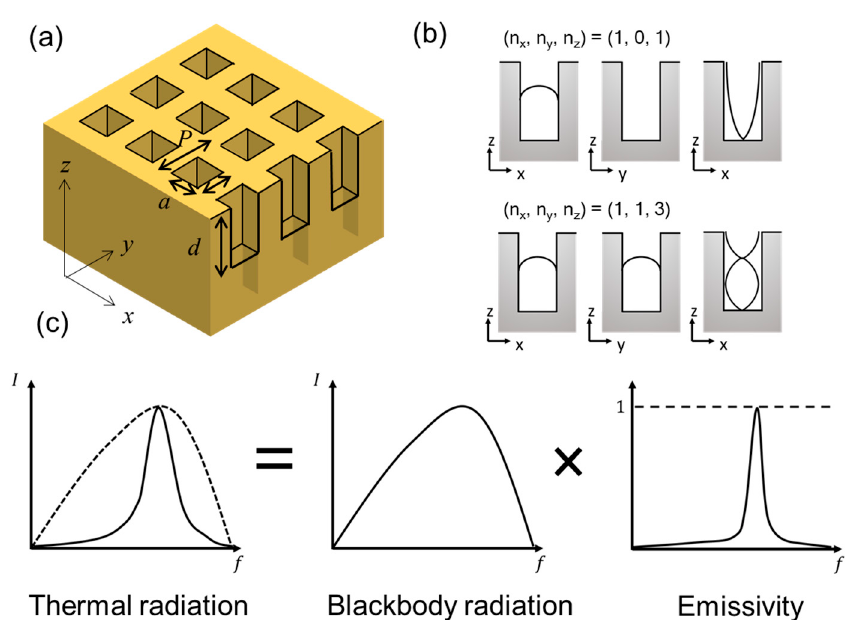
Figure 3. Principle of thermal radiation control by a metasurface: ( a ) an array of a microcavity on a refractory metal filament, ( b ) resonant modes for n = 1, 3, and 5 inside a microcavity with perfect conductor walls, and ( c ) the thermal radiation spectrum can be controlled by the product of spectral emissivity of the metasurface and Planck’s law.